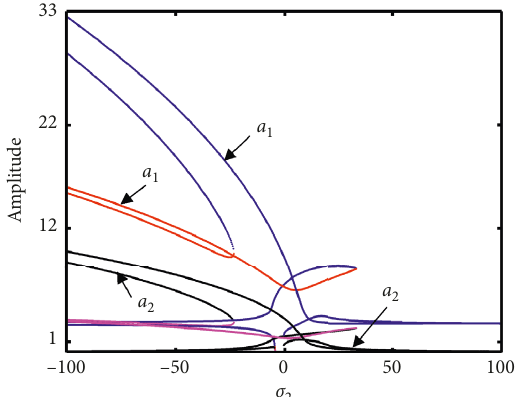
Figure 5: Frequency-response curves obtained when g g � 1 . 3, and σ 2